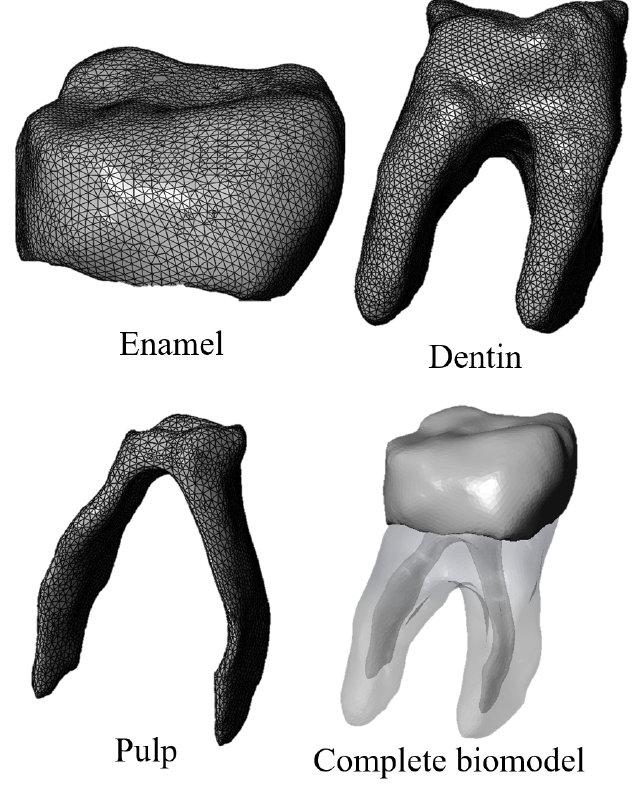
Figure 4. Biomodeling